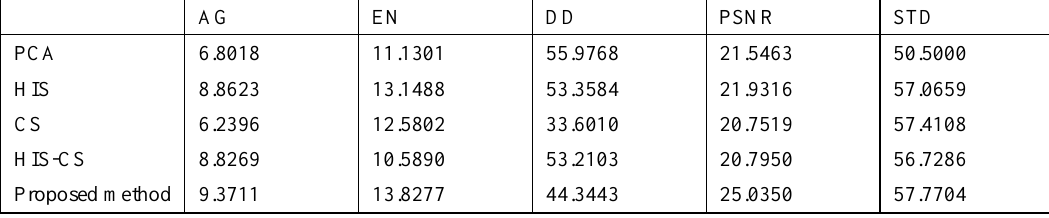
Table 1 The Comparison of various evaluation indicators with different fusion